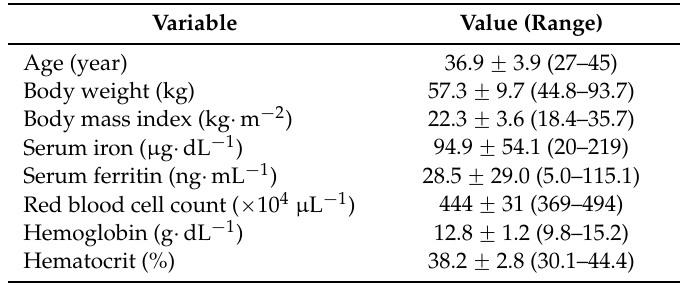
Figure 1. Participant disposition. Table 1. Baseline characteristics of the participants ( n = 35) 1 .